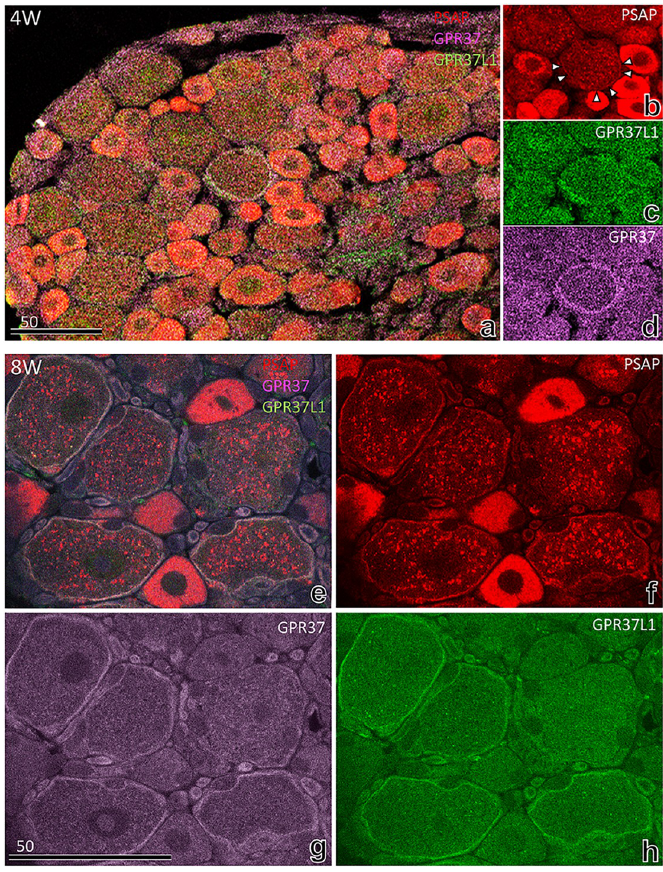
Fig 9. Immunofluorescence light micrographs stained with commercial antibodies against GPR37 (purple)/ GPR37L1 (green) at 4 and 8 weeks after birth. The results were similar to those obtained with our autonomous antibodies; fine granular PSAP in satellite cells always colocalized with both GPR-37 and GPR-37L1 in the adult DRG (e–h); in young DRG neurons, PSAP did not always colocalize with receptors (a–d). In (b), only half of the satellite cells were outlined with fine granular PSAP (white